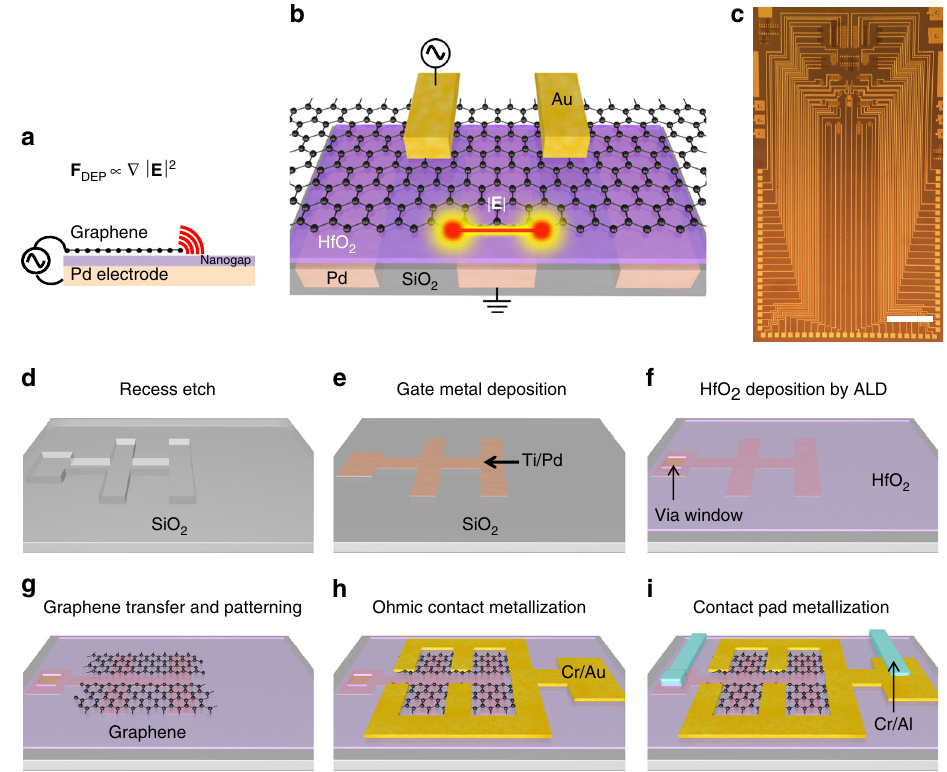
Fig. 1 Graphene as an electrode for dielectrophoresis. a Being a gradient-dependent phenomenon, DEP force is increased as the radius of curvature of an electrode is reduced. The edge of graphene could provide the smallest possible radius of curvature. b An illustration showing the region of strongest electric fi eld gradient is generated at the intersection of the edge of the graphene by applying an AC bias between the graphene contact electrode (gold) and palladium gate electrode. c A photograph of the chip. Scale bar: 2 mm. d The gate electrode patterns were created on SiO 2 substrate by combining photolithography with reactive ion etching and wet etching. e Ti/Pd layer was deposited followed by lift off to create the gate electrodes. f 8-nm-thick HfO 2 was deposited to coat the entire surface with an insulator. A via window was created for contact pad metallization with the Pd gate electrode at a later step. g Single-layer graphene grown by chemical vapor deposition process was transferred to the dielectric layer by a wet transfer process, followed by patterning using photolithography and O 2 plasma etching. h Ohmic contacts were made by photolithography, Cr/Au deposition by electron-beam evaporation and lift off. i A thick metal layer of Cr/Al was added to create low-resistance electrical leads for electrical